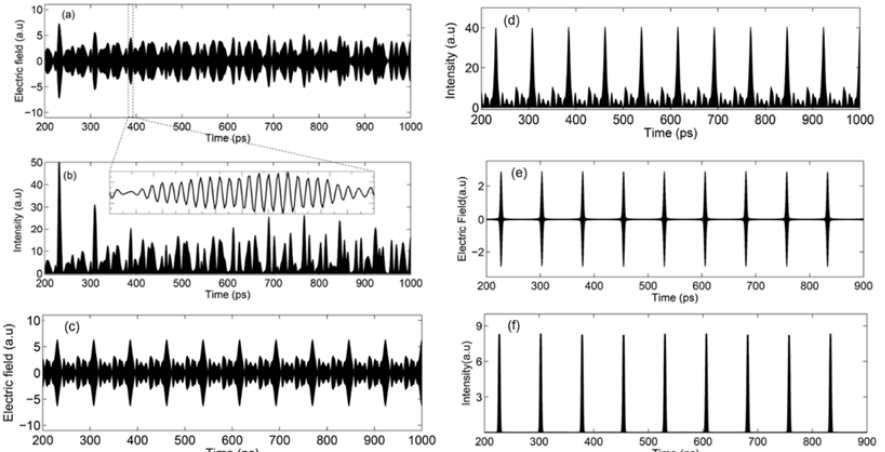
Figure 4. ( a ) Calculated electric field of laser emission from 200 ps to 1000 ps with a femtosecond time resolution with a time-dependent phase and φ m = 0. ( b ) Intensity of laser emission corresponding to ( a ). ( c , d ) Calculated lasers emission with Δ f m = 0 but phase ϕ m of each mode is different: ( c ) Electric field from 200 ps to 1000 ps and ( d ) Intensity corresponding to ( c ). ( e ) Electric field of a mode-locked laser emission as a function of time. ( f ) Intensity corresponds to the electric field above. As discussed above, the key mission of mode-locking is to remove or fix the time dependent phase term and make the mode spacing and phase of a laser to be identical.